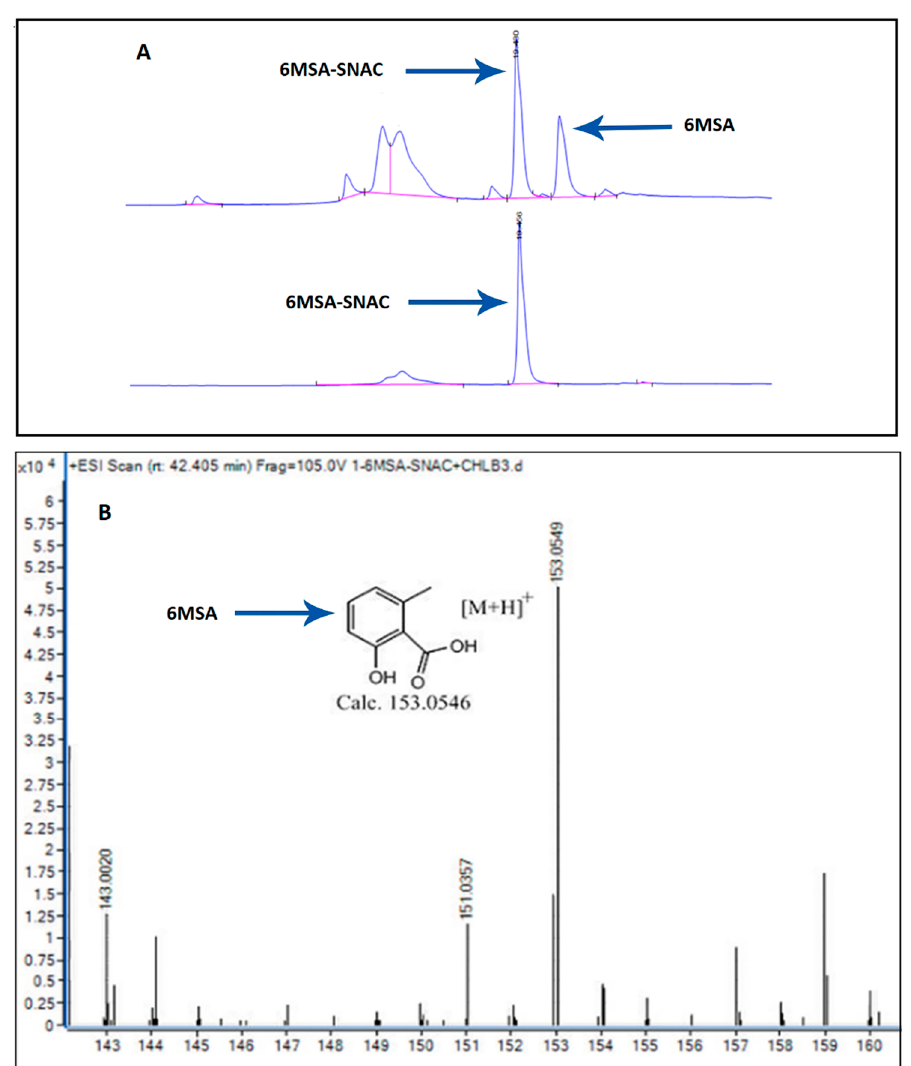
Figure 5. Chromatographic analysis of 6MSA produced from 6MSA-SNAC in response to hydrolysis. ( A ) HPLC profile showed the production of 6MSA as compared to standard 6MSA-SNAC. A single higher peak indicated the control and the hydrolyzed 6MSA was exhibited with smaller peak. ( B ) The observed result was labeled on mass spectra.